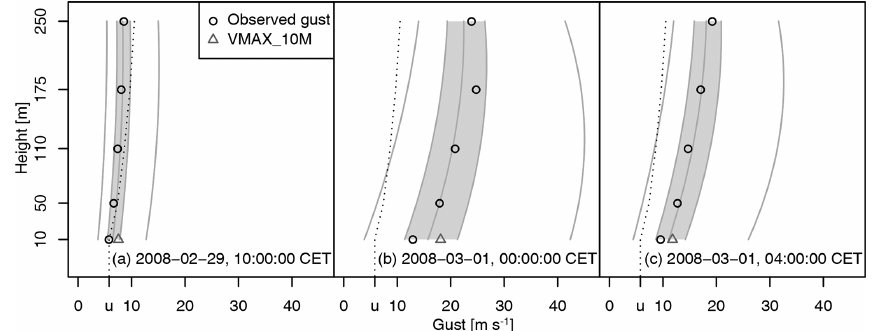
Figure 10. Vertical post-processing of gusts using the Legendre model for times highlighted in Fig. 9. The grey solid lines indicate the